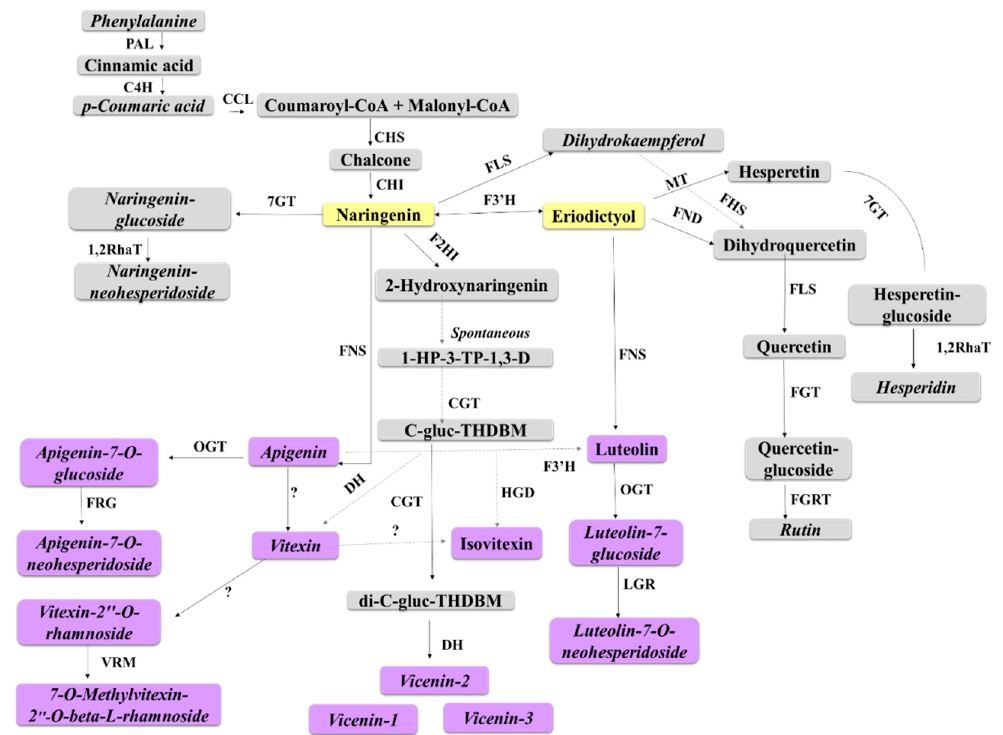
Figure 8. Schematic representation of the proposed biosynthetic pathway of defence-related flavonoids in sorghum. This pathway displays some of the flavonoids annotated in sorghum plant extracts following infection with B. andropogonis . Solid lines represent main routes and dashed lines represent alternative routes. Abbreviations: PAL = phenylalanine ammonia lyase; C4H = cinnamate 4-hydroxylase; CCL = coumaryl-CoA ligase; CHS = chalcone synthase; CHI = chalcone isomerase; 7GT = flavanones-7- O -glucosyltransferase; Cm1,2RhaT = 1,2 rhamnosyltransferase; F2HI = flavanone-2-hydrohlyase; FNS = flavone synthase; OGT = O -glycosyltransferase; FRG = flavanones 7- O -glucoside-2”- O - β - L -rhamnosyltransferase; LGR = luteolin 2- O - β - L -rhamnosyltransferase; VRM = vitexin 2”- O -rhamnoside 7- O -methyltransferase; MT = methyltransferase; FND = flavanones 3-dioxygenase; FLS = flavonol synthase; FGT = flavonoid 3- O -glucosyltransferase; FGRT = flavonol-3- O -glucoside L -rhamnosyltransferase; FHS = flavonoid 3’,5’-hydroxylase; CGT = C -glycosyl transferase; HGD = 2-hydroxynaringenin-6- C -glucoside dehydratase; DH = dehydrogenase; ? = enzymes not yet characterised. Metabolites annotated in this study are in italics . Flavones and derivatives are indicated in purple and the flavanone precursors in yellow.